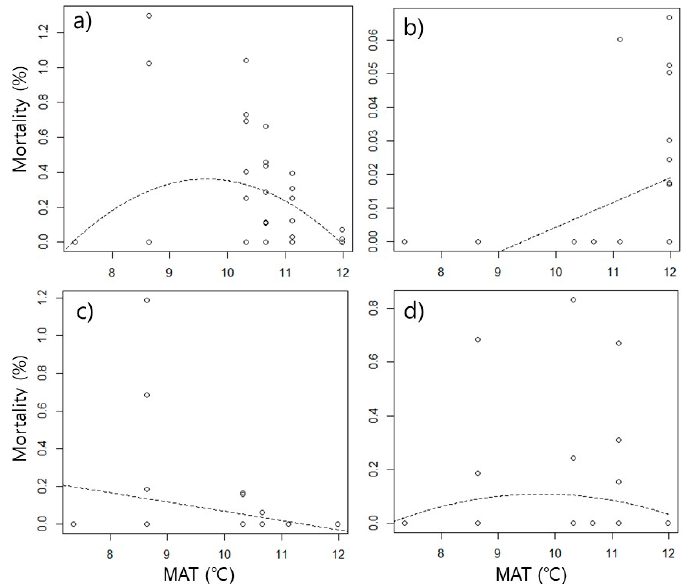
Figure 3. Mortality rate (%) of abundant ant species caused by food competition along temperature gradient. ( a ) Mortality of Nylanderia flavipes from interspecific competition, ( b ) mortality of N. flavipes from intraspecific competition, ( c ) mortality of Aphaenogaster japonica from interspecific competition, and ( d ) mortality of A. japonica from intraspecific competition. The experiment was performed with eight replicates at each temperature condition, and their mortality rates were presented in the scatter plot. The fitted lines are based on the linear or quadratic regression models according to significant influences shown in Table 6. MAT: mean annual temperature.